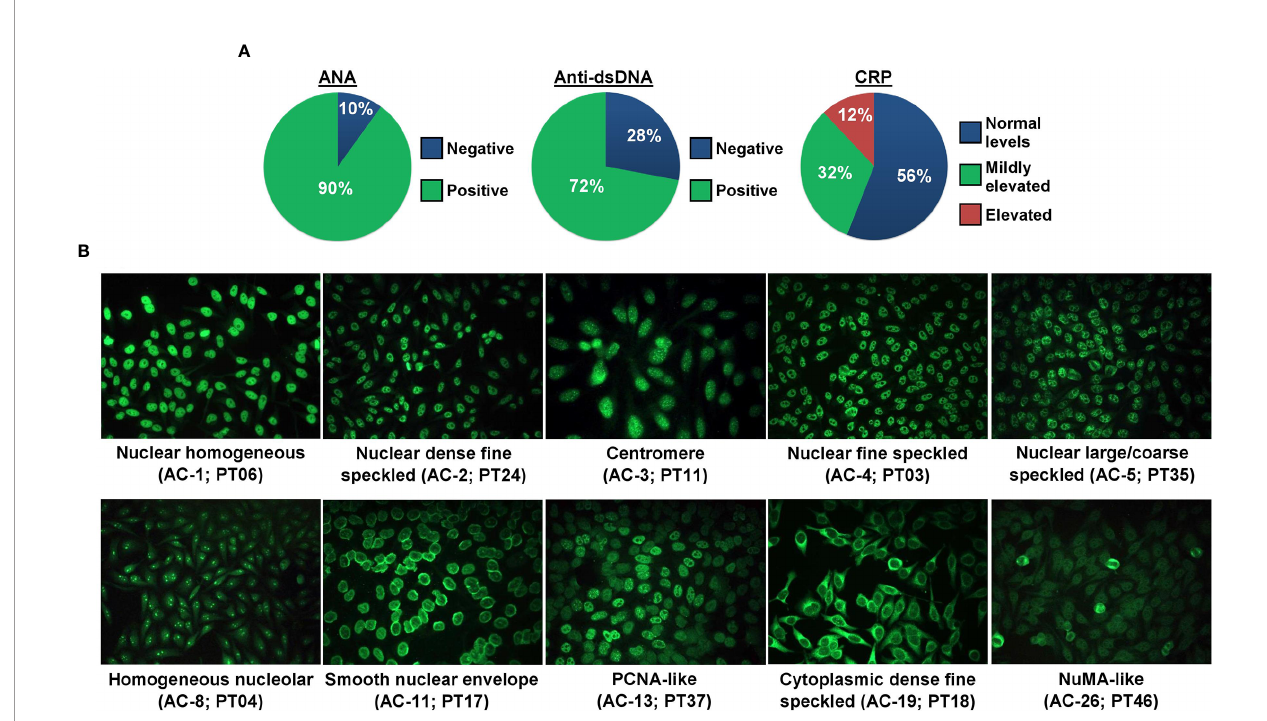
FIGURE 1 | ANA, anti-dsDNA, and CRP status of SLE patients. (A) The proportion of SLE patients (n = 50) positive or negative for ANA and anti-dsDNA, and negative, mildly elevated, or elevated for CRP. (B) ANA patterns of SLE patients. Ten ANA patterns were observed in our cohort of SLE patients and each pattern is shown by a representative case. The ICAP HEp-2 IIFA pattern in alphanumeric code and the patient ID are stated in brackets.